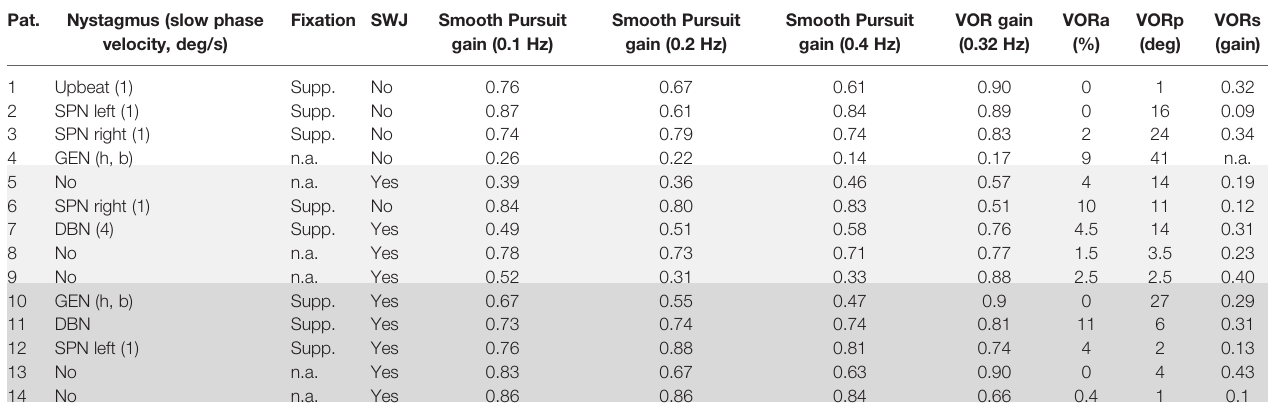
TABLE 2 | Additional ocular motor and vestibular fi ndings. Pat.